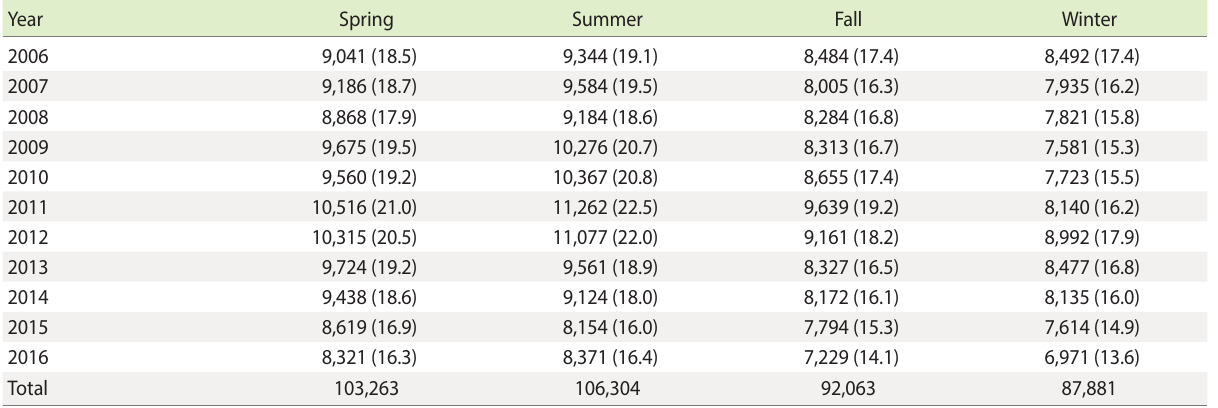
Values are presented as number (crude rate).